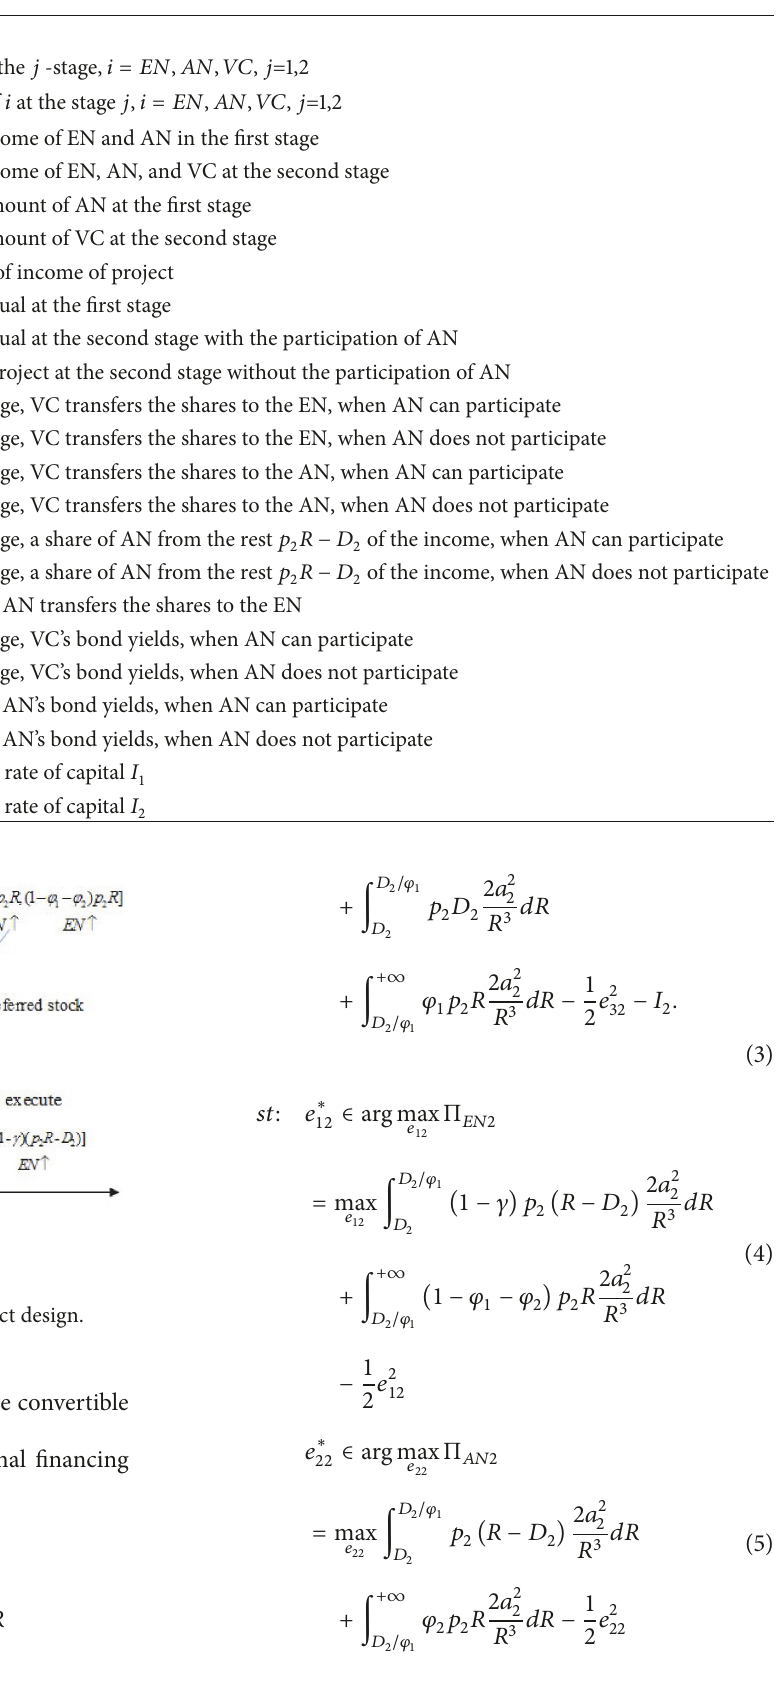
Table 1: The variables and symbols.